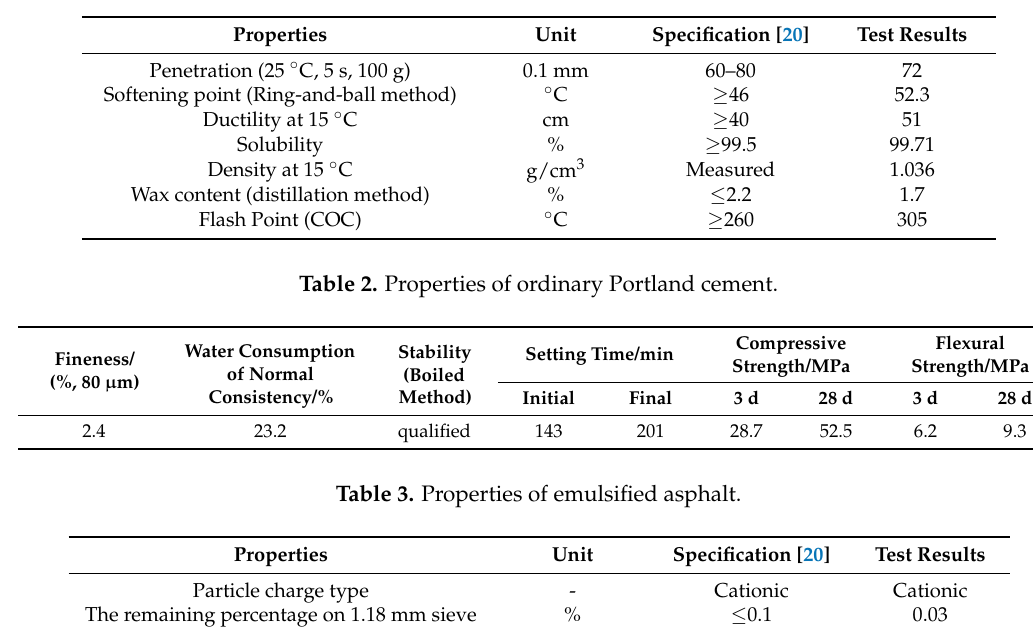
Table 1. Properties of asphalt binder.